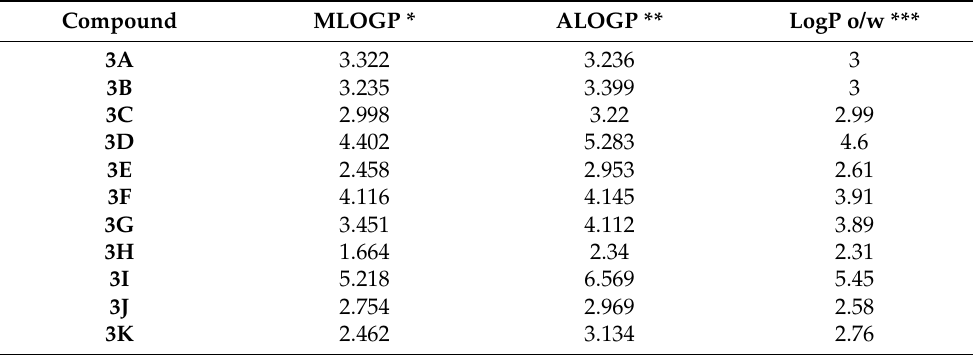
Table 3. Theoretical parameters of lipophilicity for tested compounds. Compound MLOGP * ALOGP ** LogP o/w ***